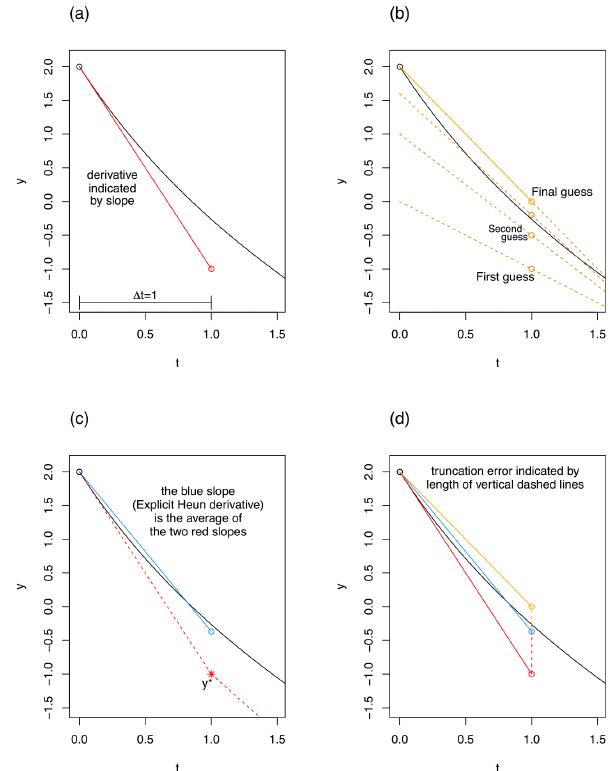
Figure 2. Examples illustrating a single step of explicit Euler (a) , implicit Euler (b) , explicit Heun (c) , and a comparison of all three (d) . A single differential equation rather than a system is solved, given by y (cid:48) = − y(x(t)) − x(t) − 1, y(x( 0 )) = 2, where x(t) = t for simplicity. The black curve is the exact solution to this linear differential equation. Each approximation method uses a time step of 1 in these